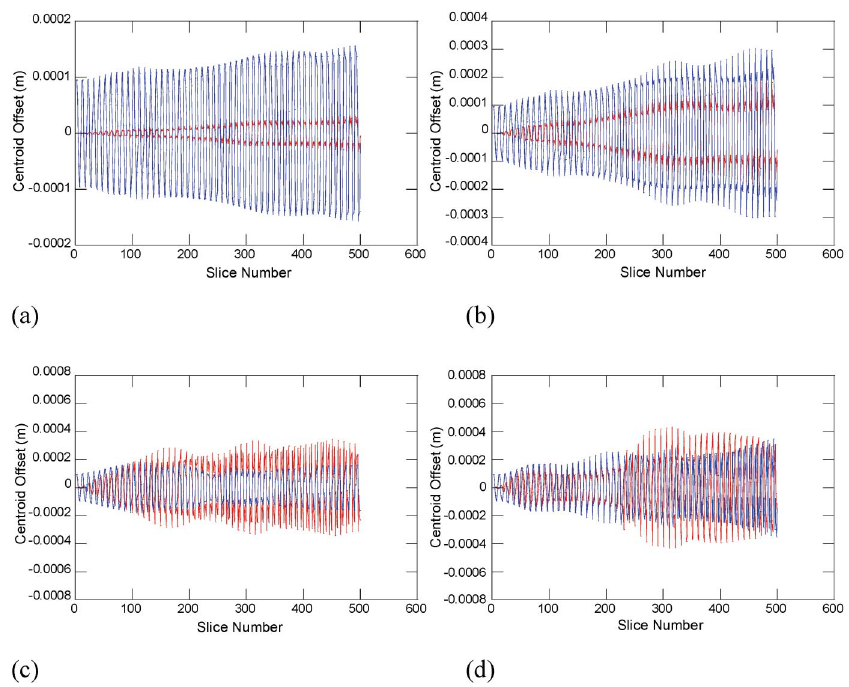
FIG. 16. (Color) Electron-beam centroid evolution for 20-MeV, 3-mm, resonant beam case at different axial positions. Each slice is 0.4 nsec long. The red line is for the horizontal offset and the blue line is for the vertical offset. (a) z (cid:4) 0 : 625 m , (b) z (cid:4) 1 : 25 m , and (c) z (cid:4) 2 : 5 m , and (d) z (cid:4) 5 m